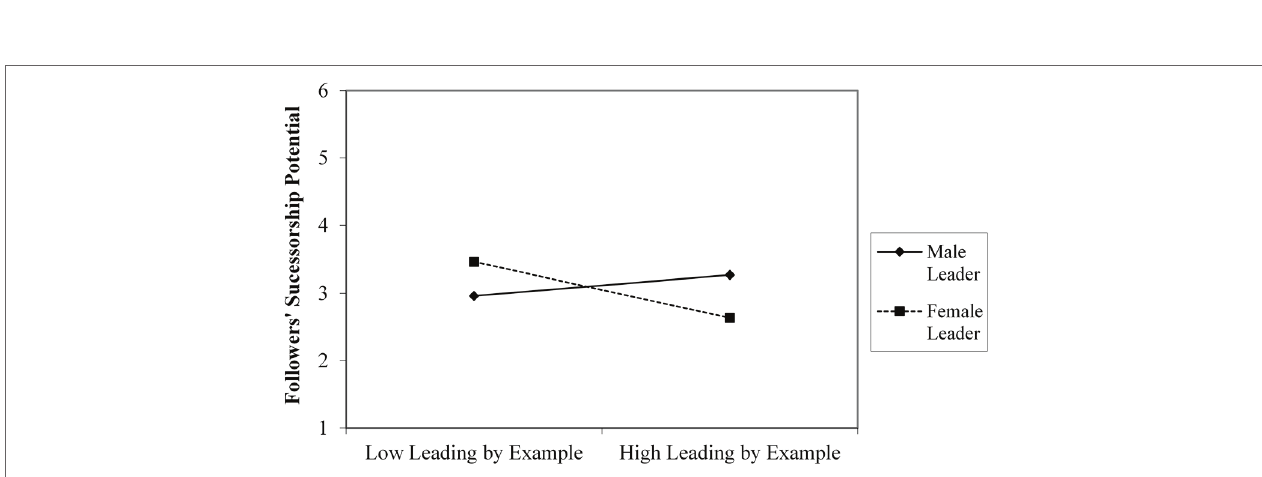
FIGURE 1 | Interactive relationship of followers’ evaluation of leaders’ use of coaching and leader gender with leaders’ assessment of followers’ successorship potential (study 1).